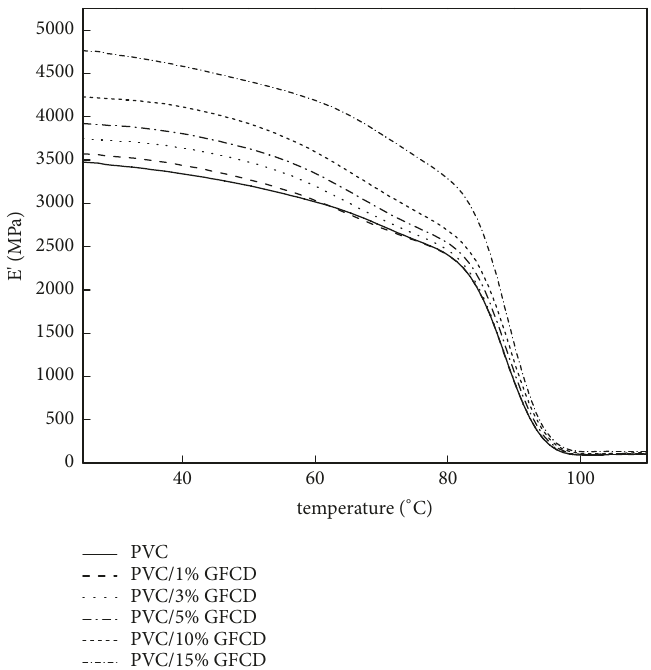
Figure 11: The relationship between the storage modulus E 󸀠 versus the temperature of PVC and PVC/GFCD